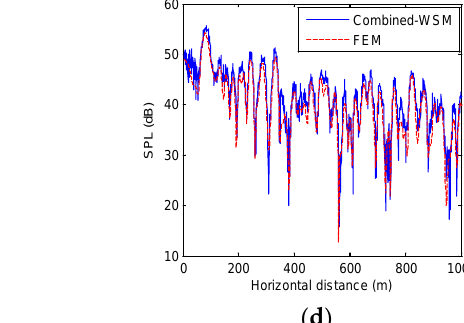
Figure 7. The SPL at the depth of 25 m and 50 m (100 Hz). ( a ) The depth of 25 m; ( b ) The depth of 50 m; ( c ) The depth of 100 m; ( d ) The depth of 150 m.